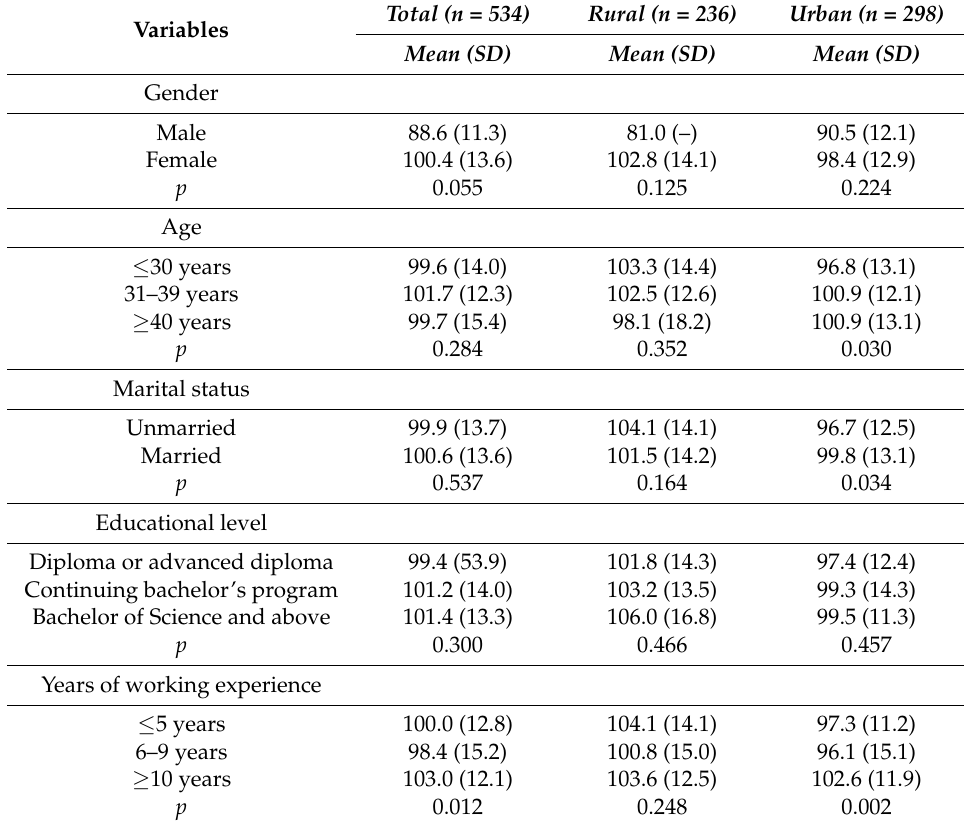
Table 3. Univariate analysis of association between nurses’ characteristics and attitudes toward online